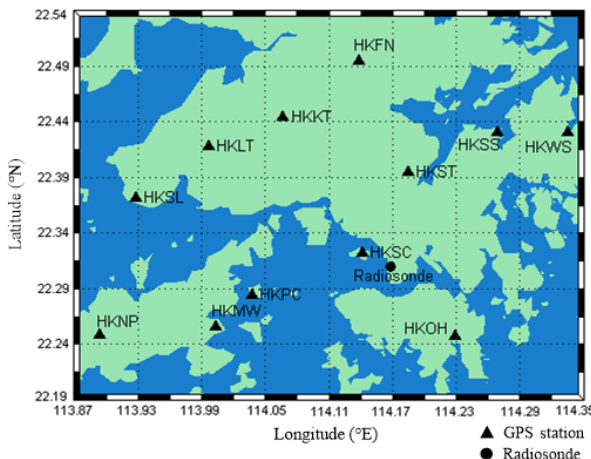
Figure 2. Geographic distribution of ground-based GPS, and ra- diosonde, stations in the research